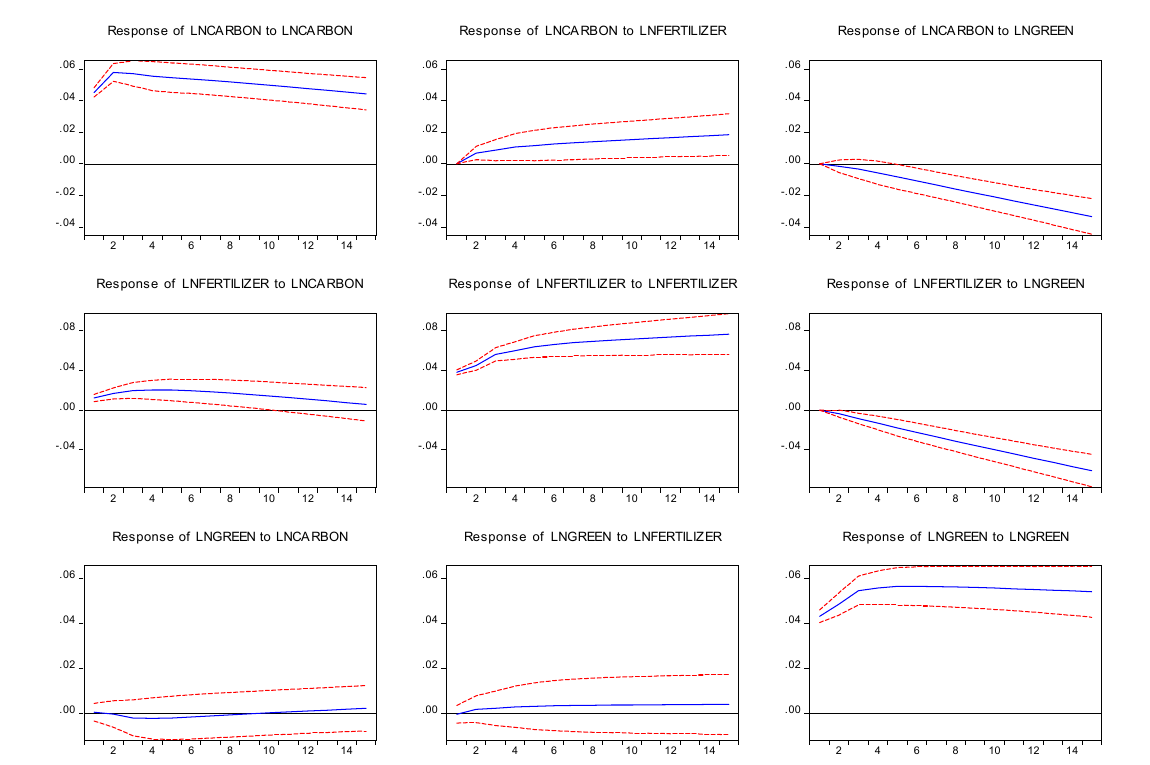
Figure 2. Impulse response of lncarbon, lngreen, and lnfertilizer for prediction of 14 years (blue color) with 95% of confidence interval (red color).